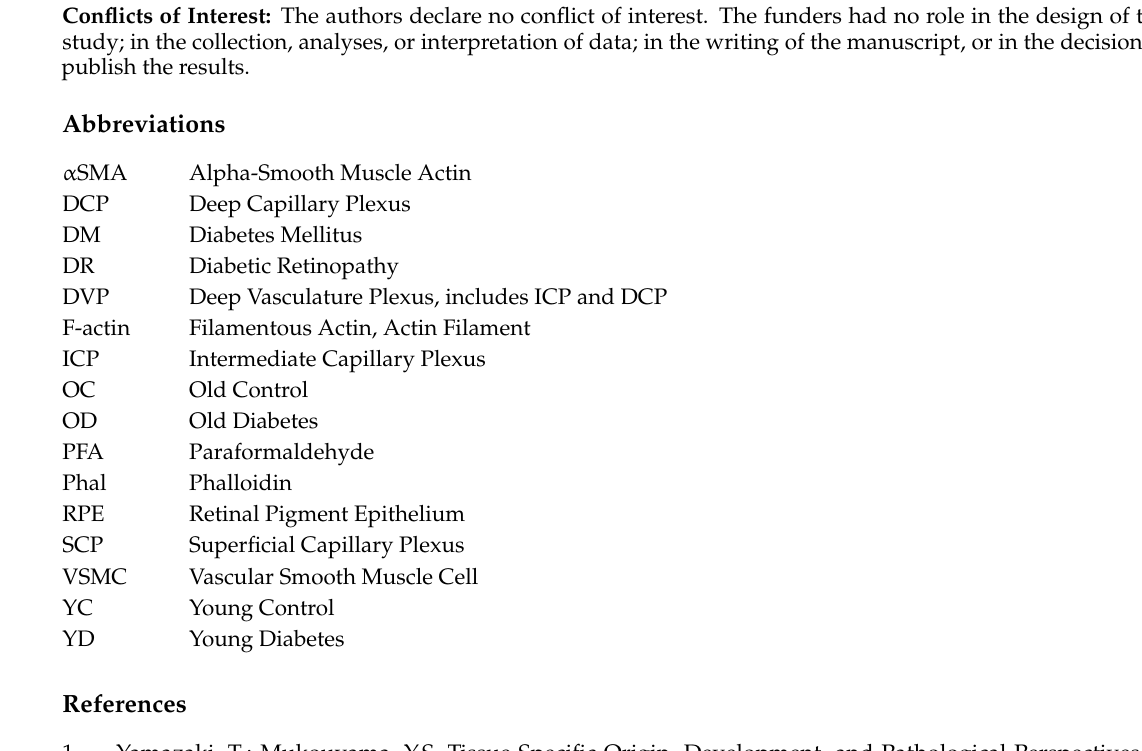
s1. Figure S1: Induction of transparent choroid by bleaching of choroidal melanocytes and RPE pigments in C57Bl / 6 mouse. Figure S2: α SMA expression in capillaries of the retina and